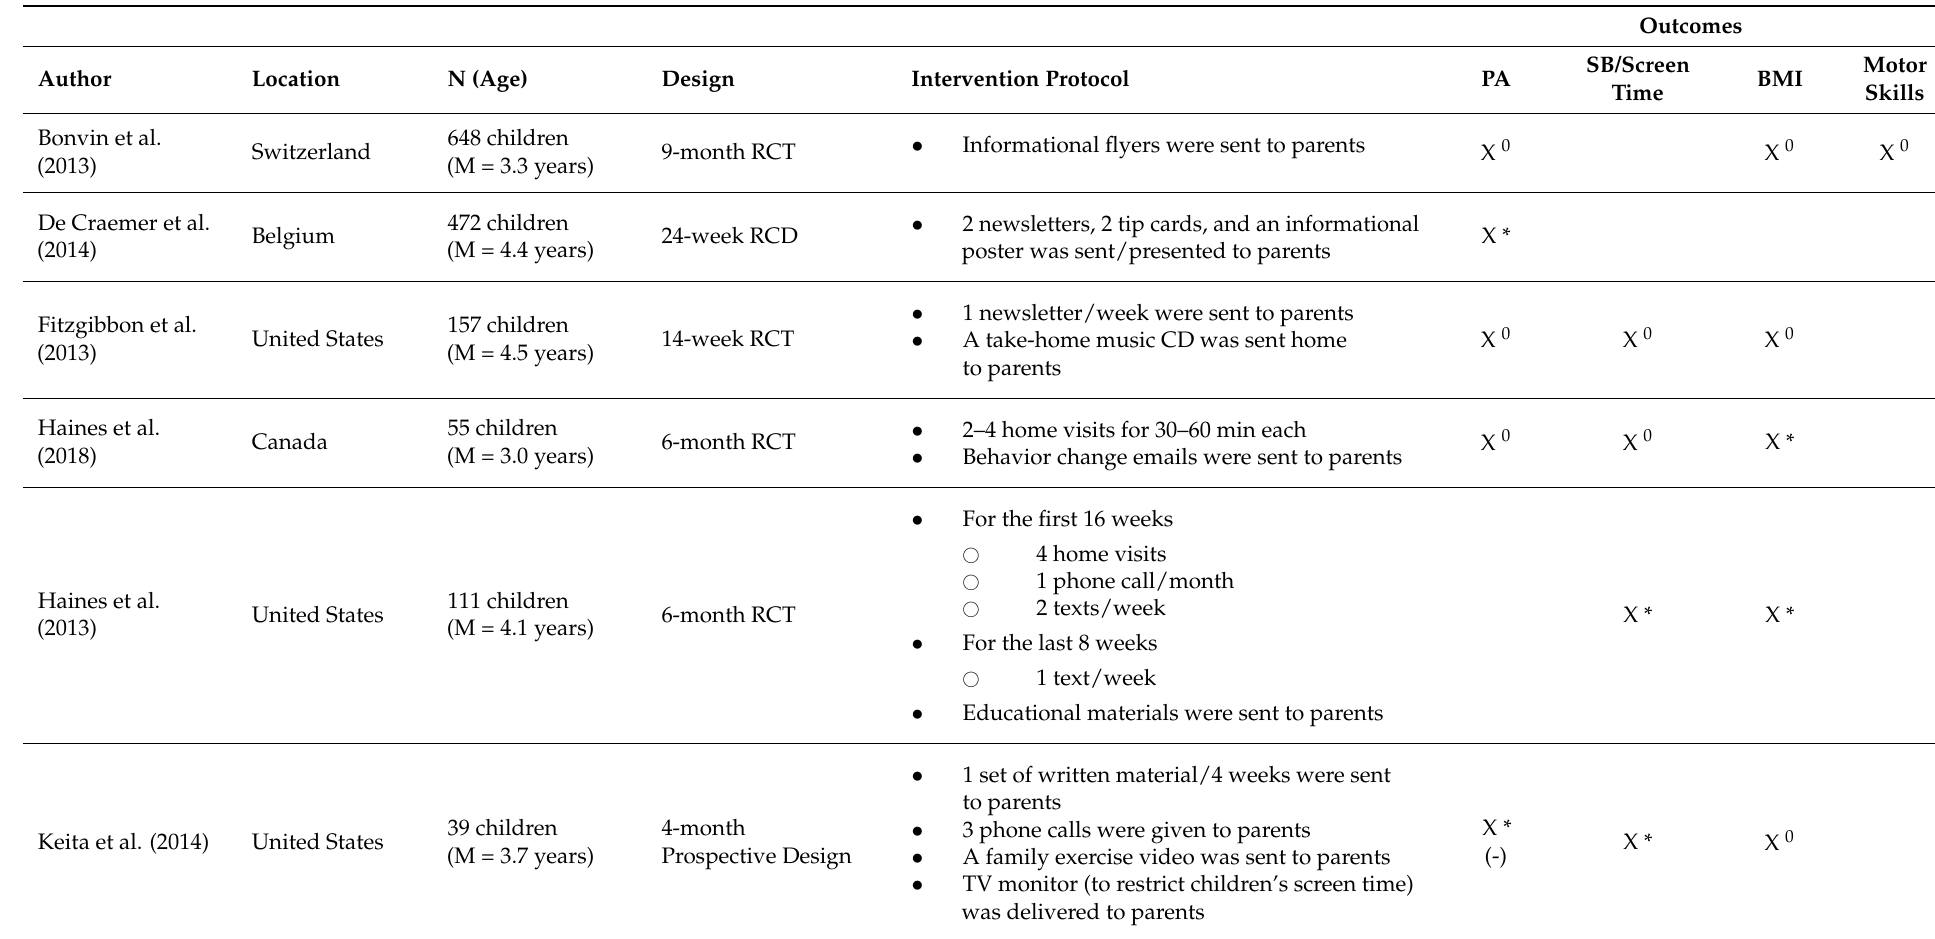
Table 3. Intervention effects of home/family-based intervention (n =